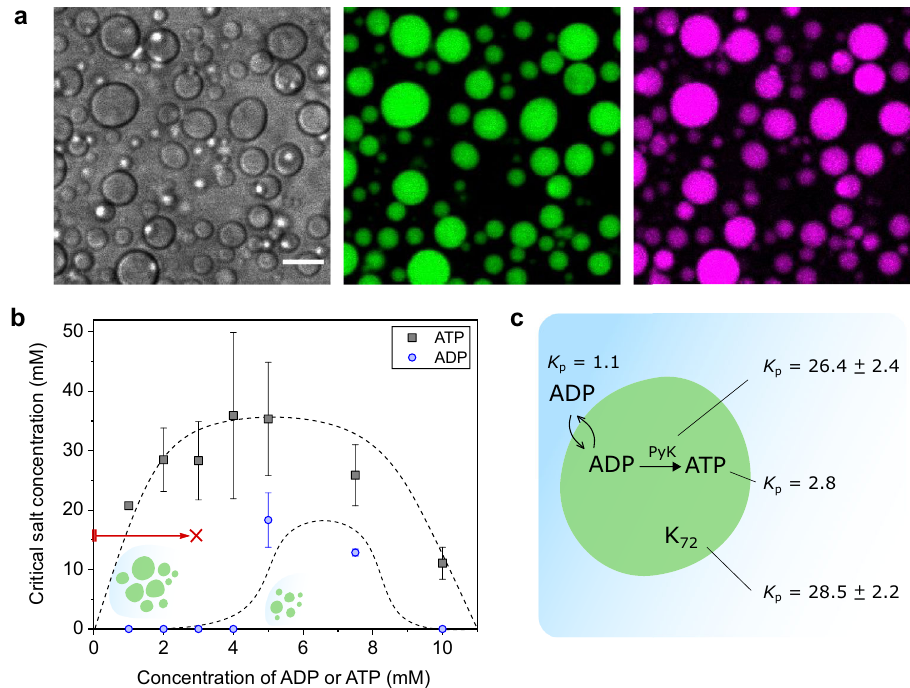
Fig. 2 Main properties of ATP-K 72 coacervate droplets. a ATP-K 72 droplets containing Alexa Fluor-647-labeled pyruvate kinase. Channels are shown separately: gray (left) — transmission, green (middle) — GFP (attached to K 72 ), magenta (right) — Alexa Fluor-647. K 72 always contains the GFP tag; PyK was labeled with Alexa-647 only for this experiment. Scale bar: 10 μ m. b The phase diagrams of ADP-K 72 and ATP-K 72 mixtures con fi rm that the conversion of ADP to ATP can induce coacervation under certain conditions and lead to growth (e.g., along the red line). The dashed lines representing the approximate phase boundaries are meant as a guide to the eye. Error bars represent one standard deviation of the intercept value in the linear fi t used to determine critical salt concentration from a turbidity assay (see “ Methods ” , based on fi ve turbidity measurements). Source data are provided in Supplementary Data 1. c Partitioning coef fi cients of the main components (measured via HPLC or fl uorescence, see Supplementary Figs. 1 and